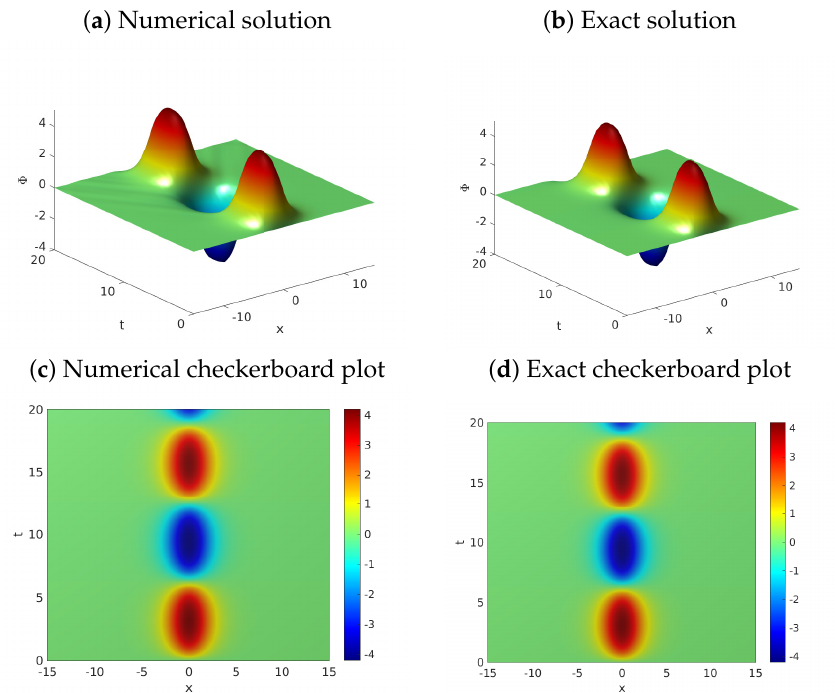
Figure 2. Comparison of the numerical solution obtained using the finite-difference method (42) against the exact solution of the mathematical model (13). In the continuous model, we considered the parameters α = β = 2, γ = 0 and F ( u ) = 1 − cos ( u ) , for each u ∈ R . The exact solution is given by the function (92). Meanwhile, for the numerical approximations we used the same model parameters with β = 1.99, Ω = ( − 15,15 ) and T = 20. Computationally, we let h = 0.5 and τ = 0.005. For convenience, the first row presents the three-dimensional surfaces for the numerical solution (left column) and the exact solution (right column). Meanwhile, the second row shows the respective interpolated checkerboard